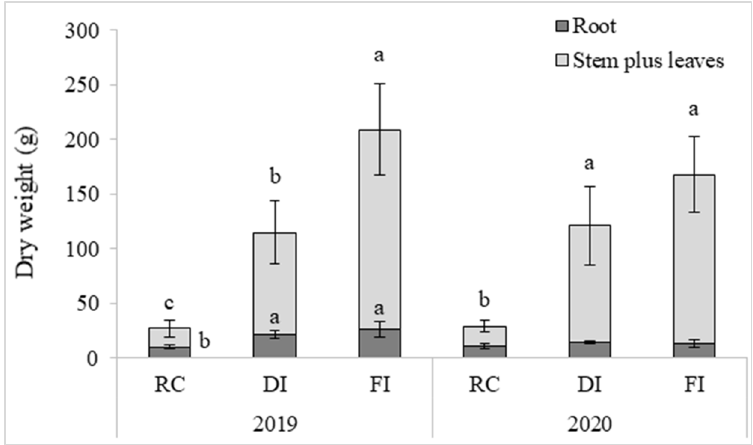
Figure 3. Maize plant stems plus leaves (light grey) and roots dry weight (dark grey). Treatments were statistically analyzed, and data with different letters indicate significant differences at ( p ≤ 0.05). Vertical bars indicate SD. Table 4. Values (± SD) of panicle marketable and not marketable yield in full and deficit irrigated treatments. Data with different letters indicates significant difference at ( p ≤ 0.05).